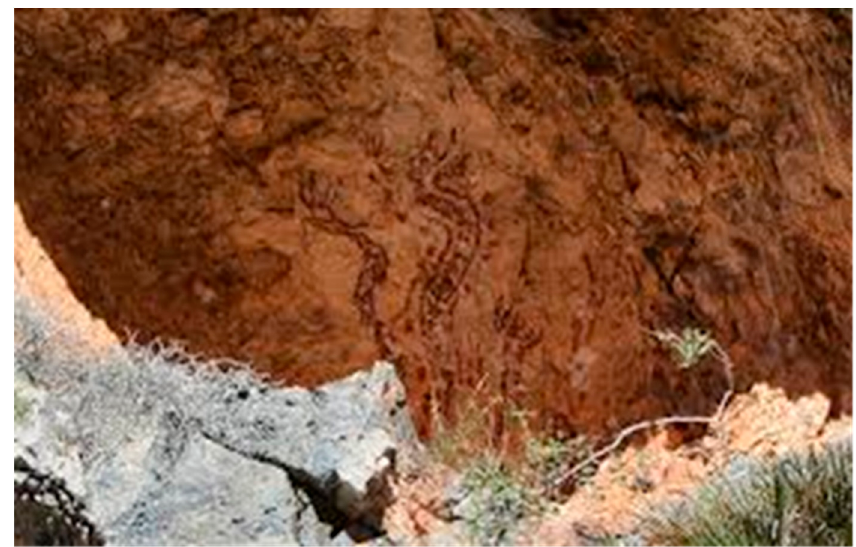
Figure 23. Concentric rings and serpentine rhythm in the images from shelter VII. This photo was taken by the author.